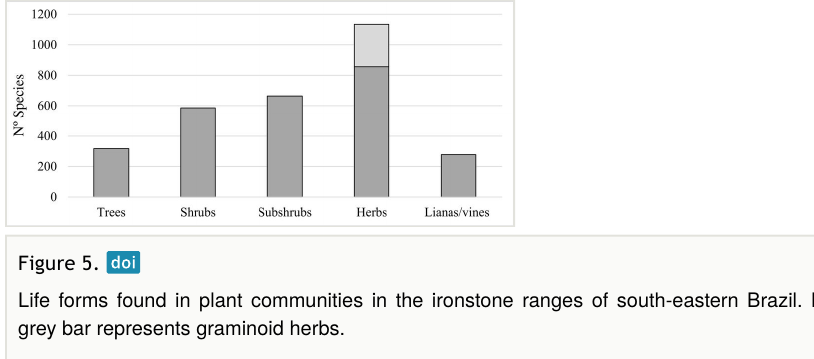
Figure 5. Life forms found in plant communities in the ironstone ranges of south-eastern Brazil. Light grey bar represents graminoid